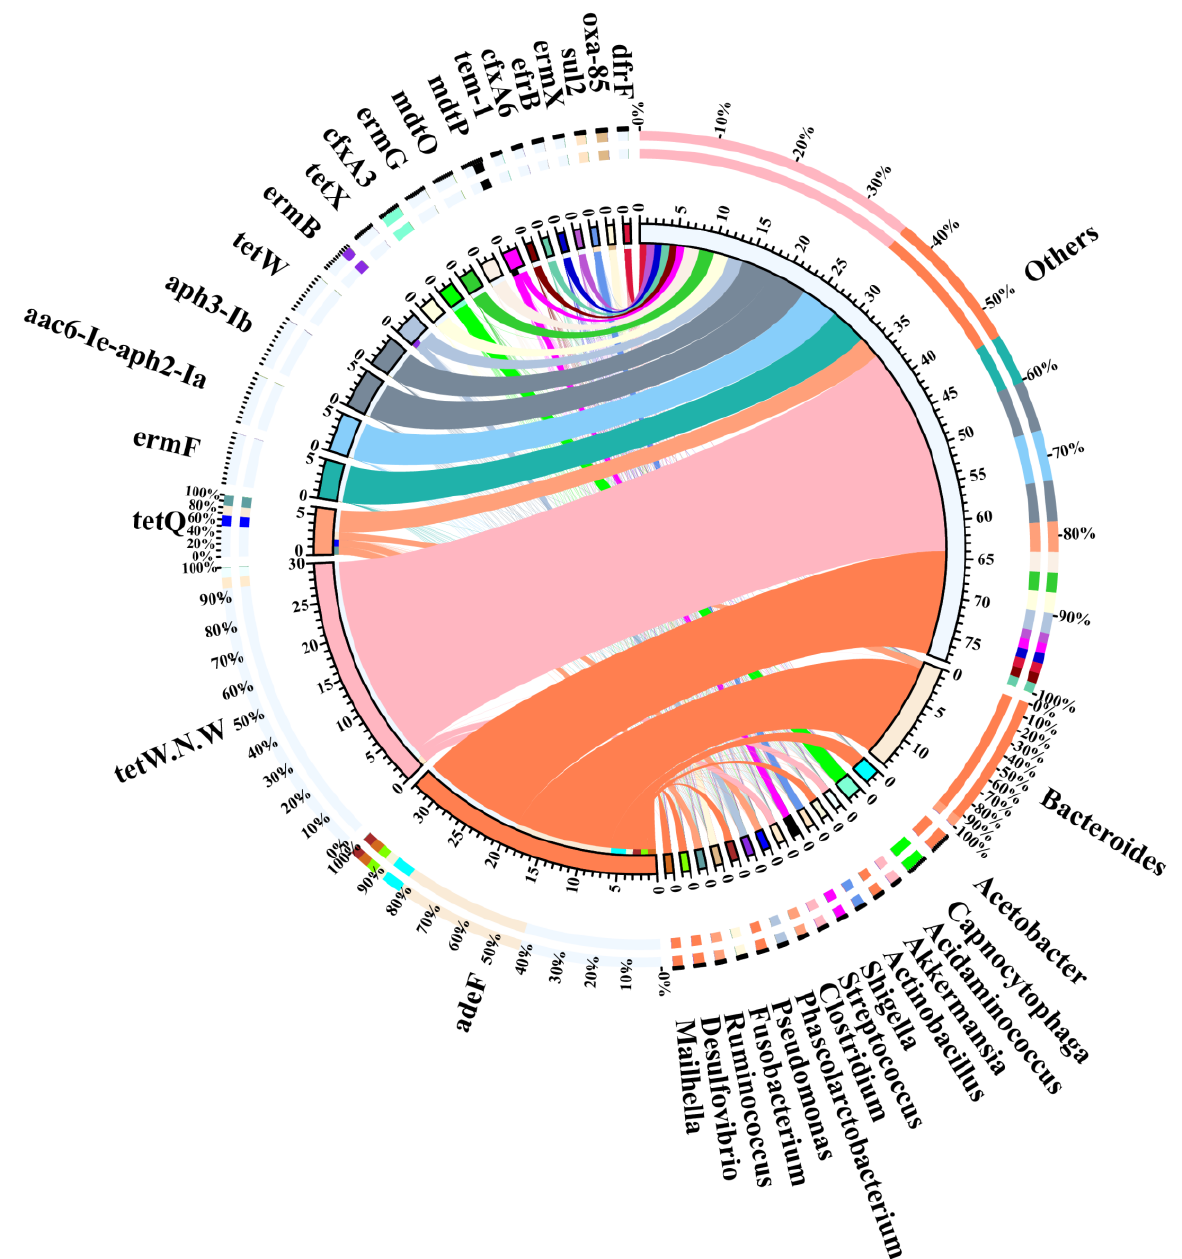
Figure 4. Analysis of the main bacterial genera carrying the top 20 antibiotic resistance gene types.